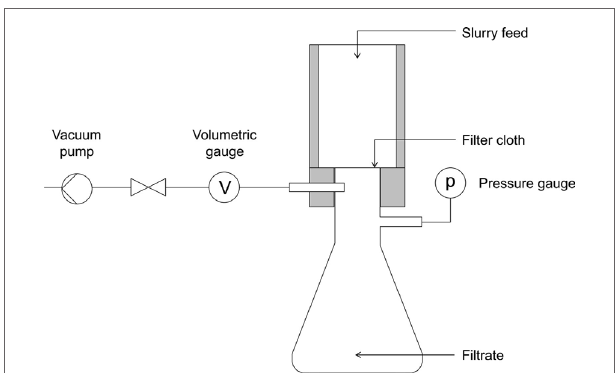
FigUre 4 | Test unit setup for vacuum filtration .